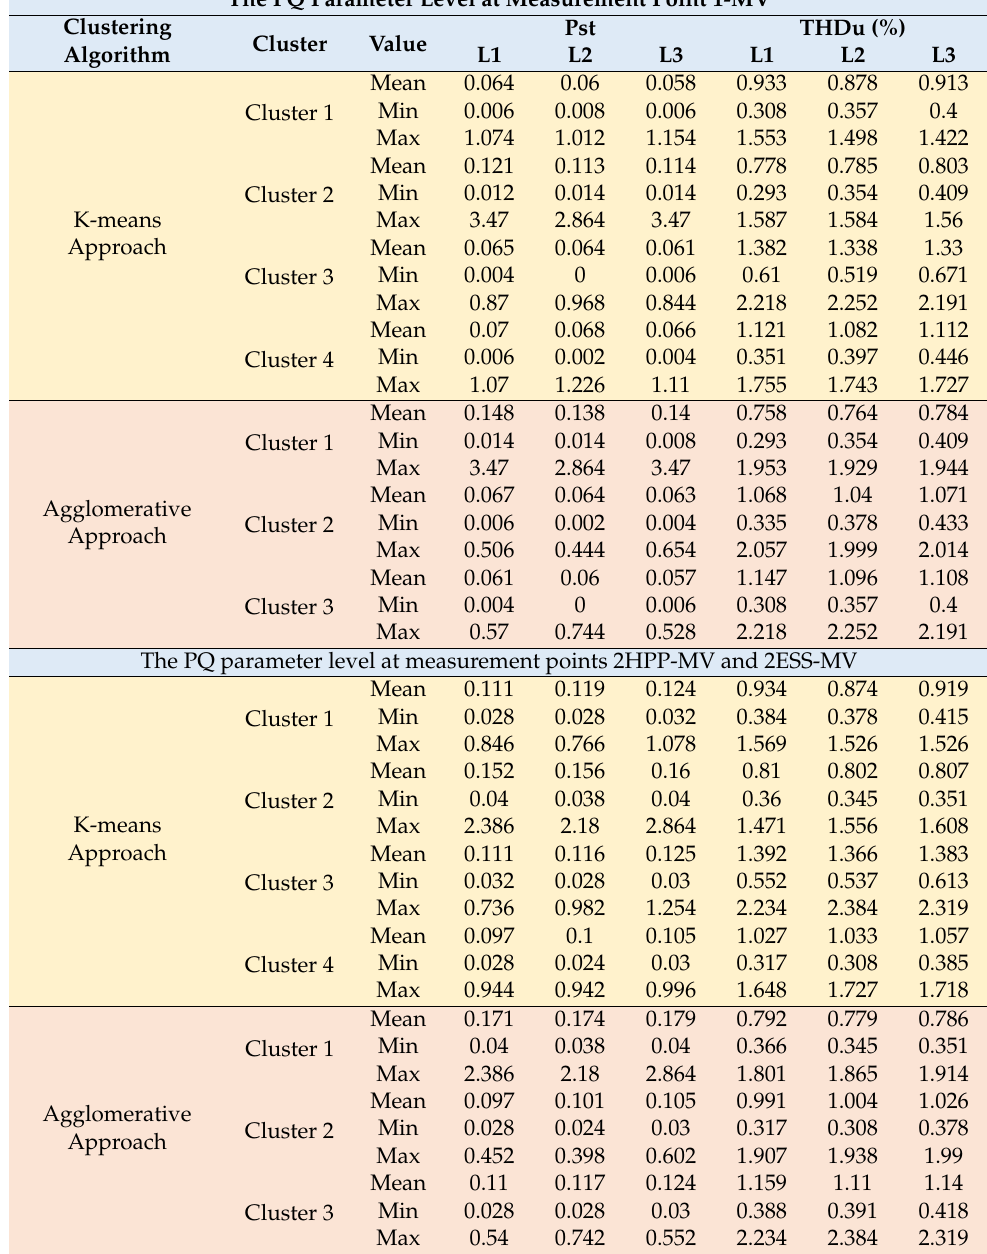
Table 3. Comparison of PQ level for different clusters on the second investigation